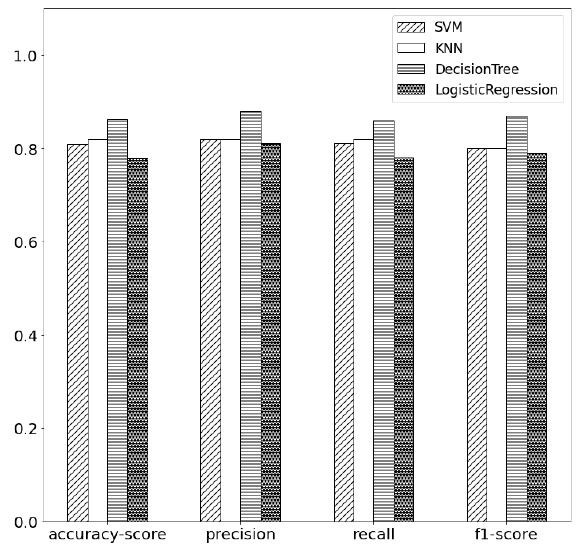
Figure 8. Classification result evaluation of each classifier.